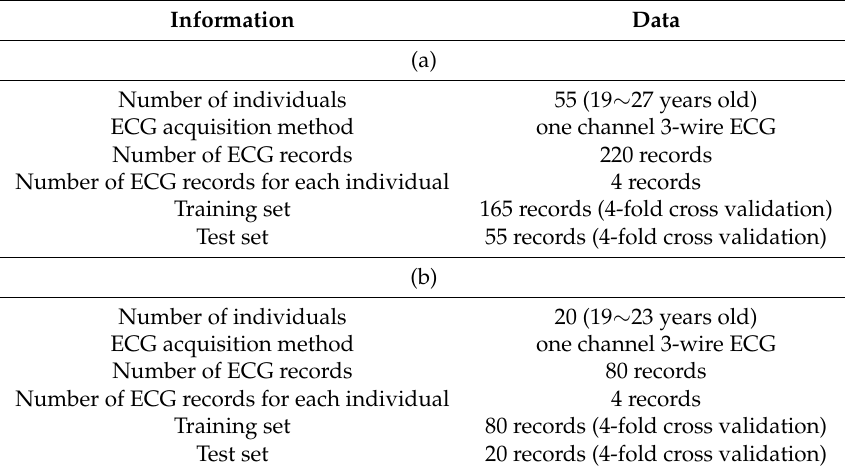
Table 1. Different recording data: (a) from the wrists; (b) from the